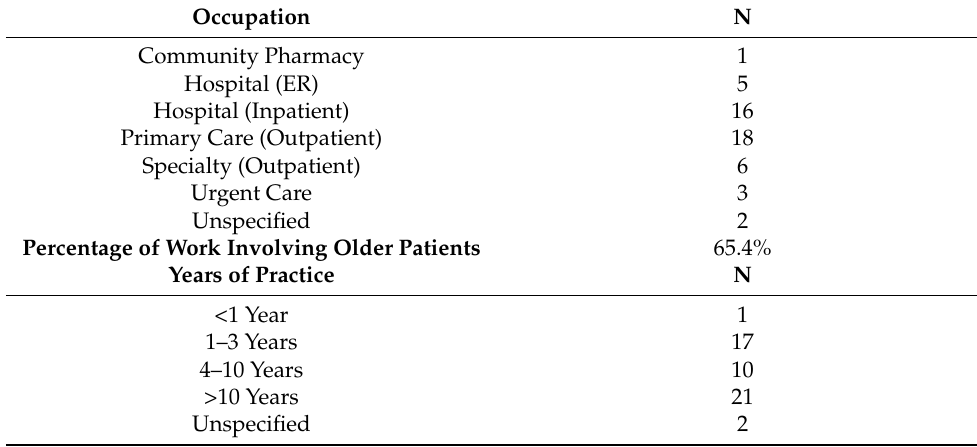
Table 1. Cont. Occupation N Community Pharmacy